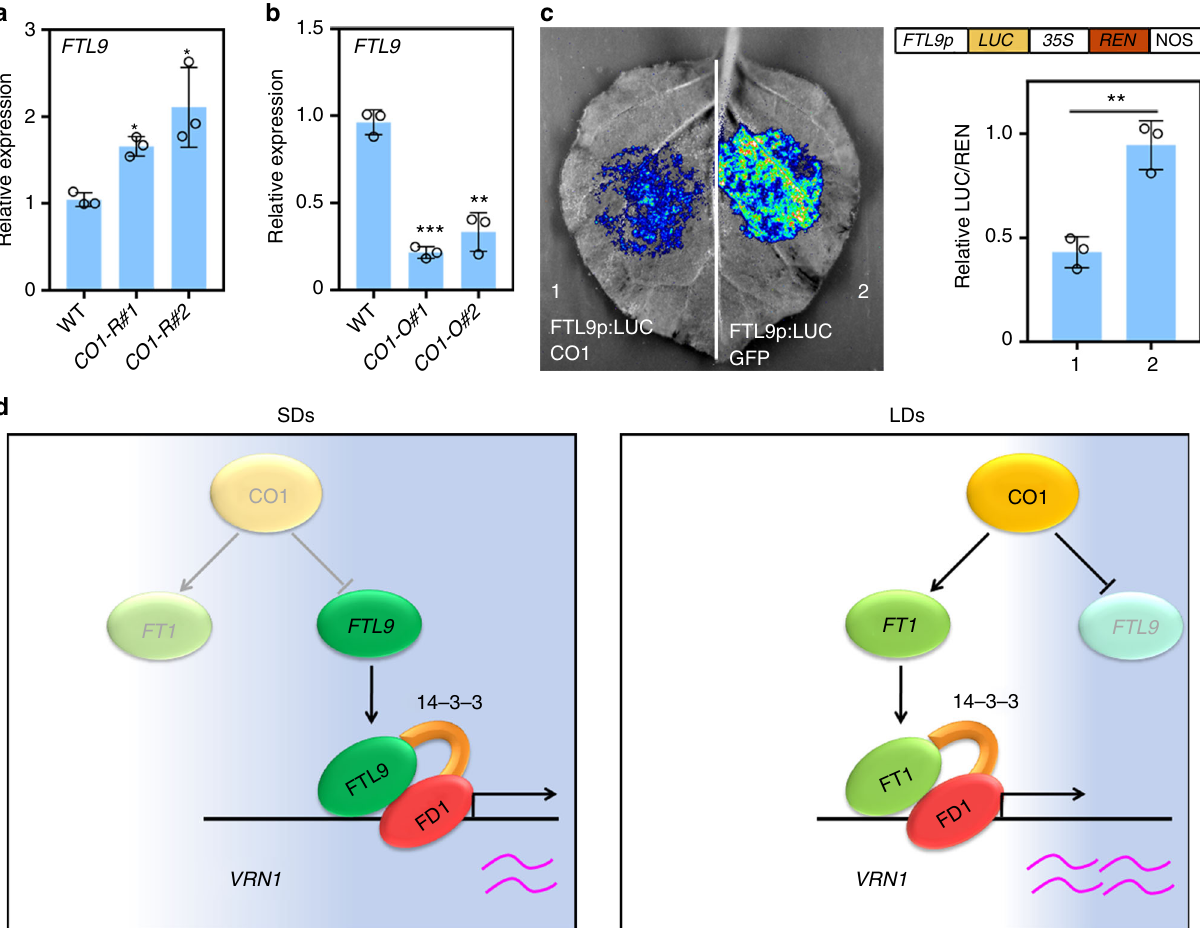
Fig. 5 CO1 negatively regulates FTL9 in B. distachyon . a qPCR analysis of FTL9 expression in four-week-old wild-type Bd21-3 and two independent CO1 - RNAi ( CO1-R ) lines under LDs. Error bars indicate s.d. (Student ’ s t test, * P < 0.05). b qPCR analysis of FTL9 expression in four-week-old wild-type Bd21-3 and